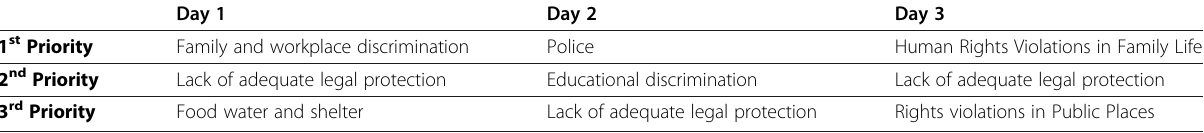
Table 2 Daily Ranking of Human Rights Violations among Sexual and Gender Minorities in Nepal Day 1 Day